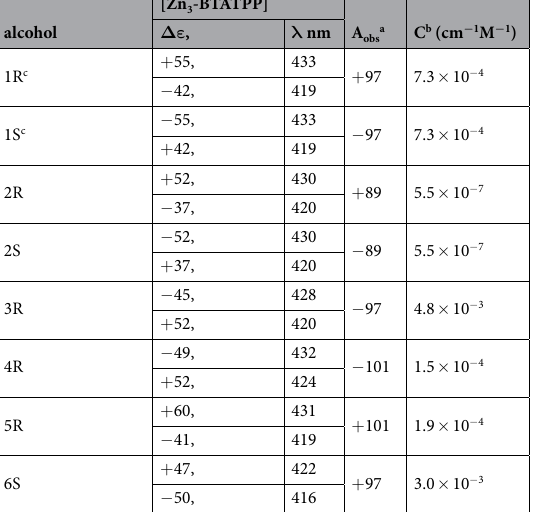
Table 1. Observed CD spectral data of chiral mono-alcohols with the host [Zn 3 -BTATPP] (1.3 × 10 − 6 M) at 295 K a A obs = Δε 1 – Δε 2 , cm − 1 M − 1 . This value represents the total amplitude of the experimentally observed CD couplets. b The concentration of the guest for the corresponding A obs . Ref. 16. All chiral reagent ee >